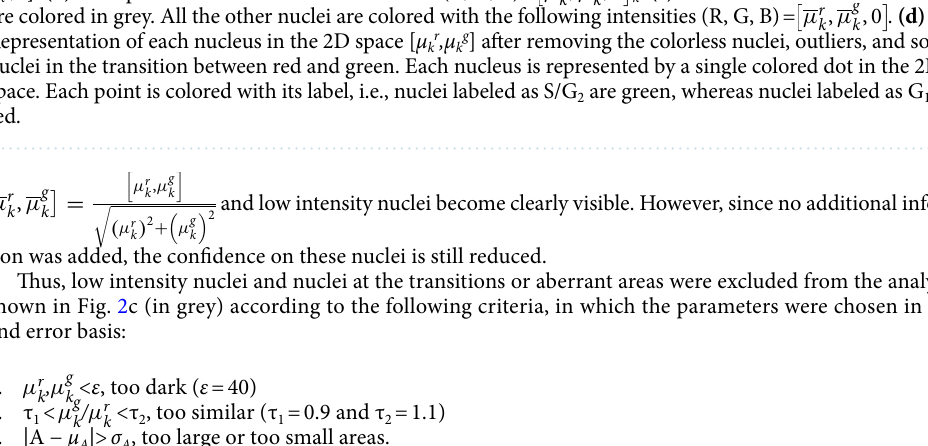
, µ g , 0 µ r k k k . (c) The nuclei that were excluded , µ g , 0 µ r . (d) (cid:31) (cid:30) k k (cid:31) (cid:30)